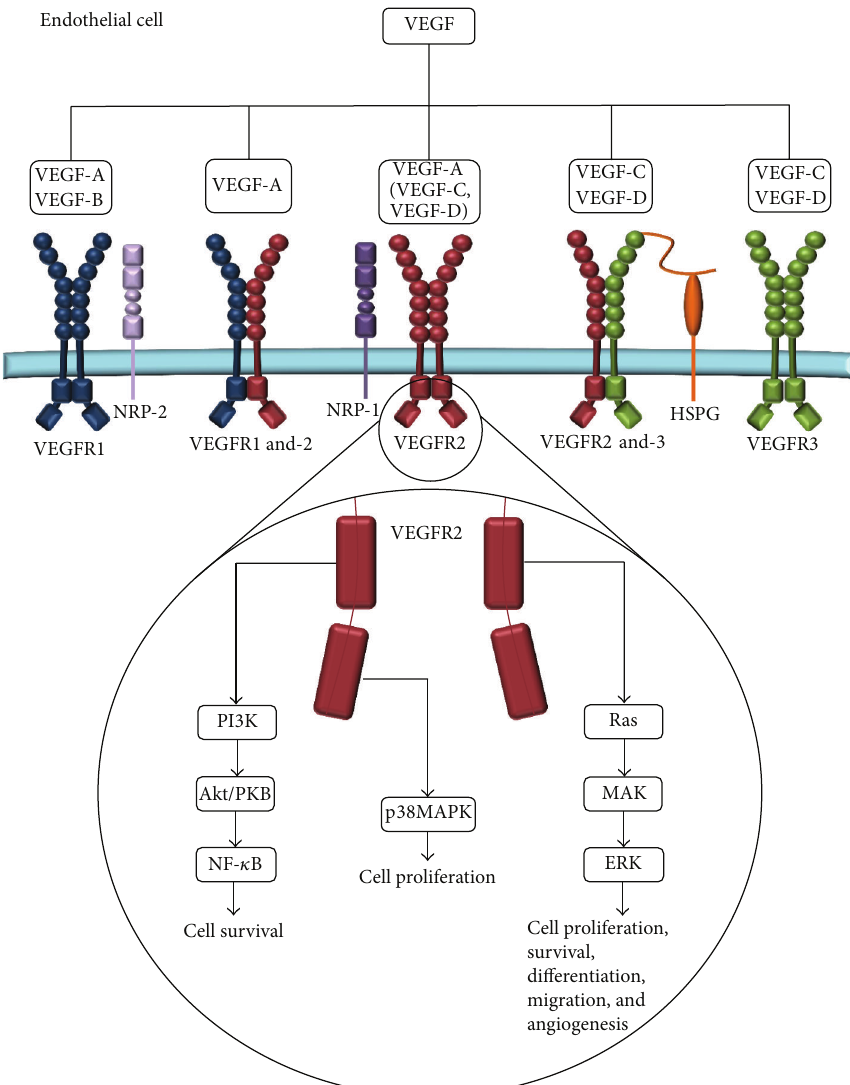
Figure1:VEGFreceptorbinding.Thefivemammalianvascularendothelialgrowthfactors(VEGF-A-D)bindtothereceptortyrosinekinases, VEGF receptor (VEGFR1-3 and co-receptors HSPG, NRP-1 and NRP-2). VEGFR-binding leads to the formation of homodimers and/or heterodimers. Proteolytic cleavage enables VEGF-C and -D to bind VEGFR-2 forming a homodimer. The binding and activation of VEGFR- 2 lead to downstream signaling of the PI3K, MAPK, and Ras pathways which promote cell survival, proliferation, differentiation, migration, and